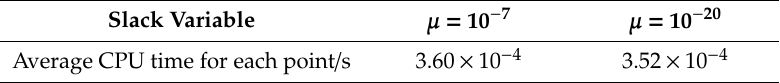
Table 2. Comparison on the central processing unit (CPU) time for di ff erent µ